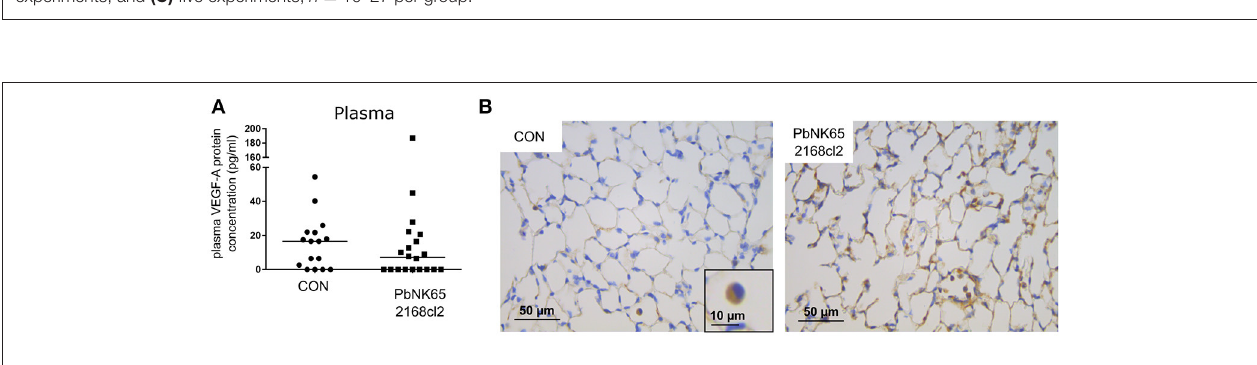
VEGFR-2 is not effective to block the pulmonary pathology in our experimental MA-ARDS